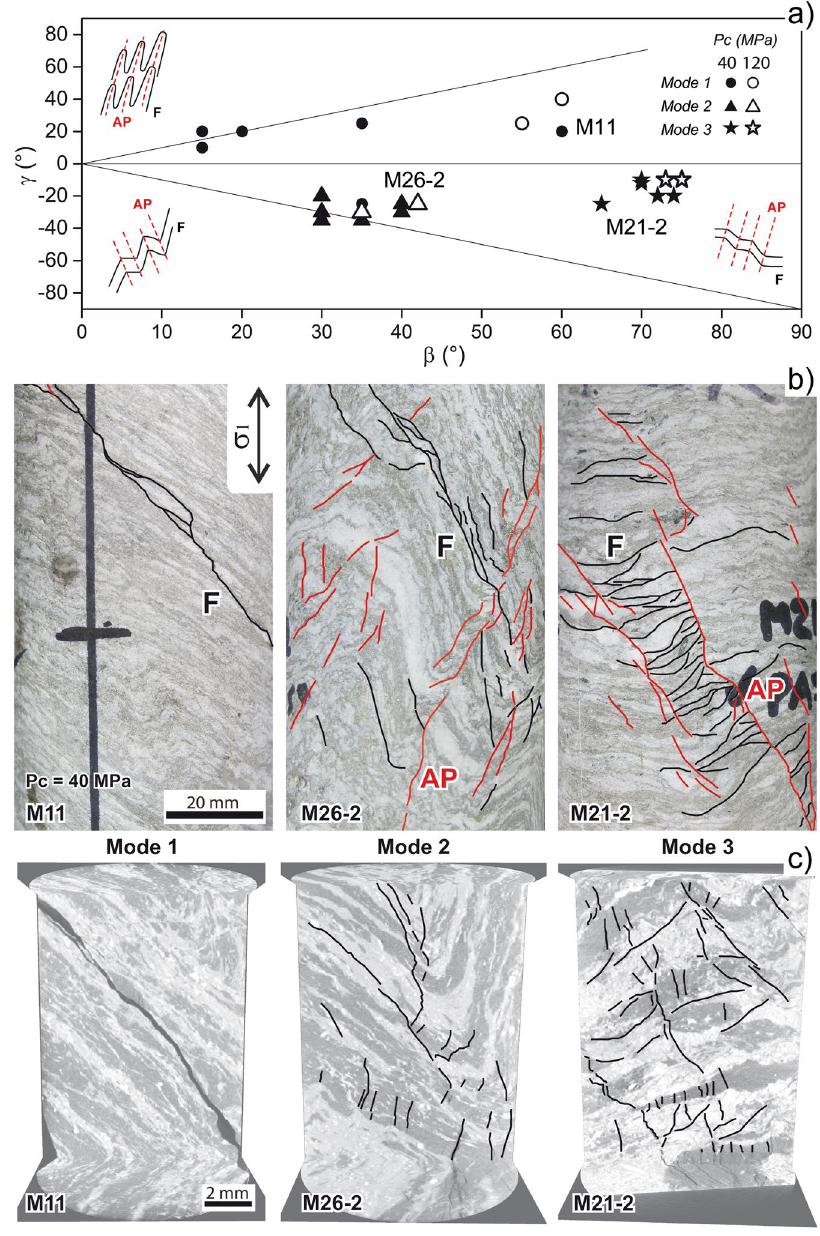
Figure 1. Failure modes of folded gneiss in triaxial compression. ( a ) β - γ plot following 4 (see Methods) summarizing the geometrical relationships among foliation ( β ), fold axial planes ( γ ) and axial load direction corresponding to different failure modes observed in compression experiments (confining P: 40 and 120 MPa). ( b ) fracture maps traced on selected failed specimens (confining P: 40 MPa); ( c ) longitudinal slices (parallel to sample axis) of high-resolution X-ray CT reconstructions (resolution 10 μ m, field of view: 9 mm, minimum resolvable crack length: 0.3 mm) with fracture maps typical of different failure